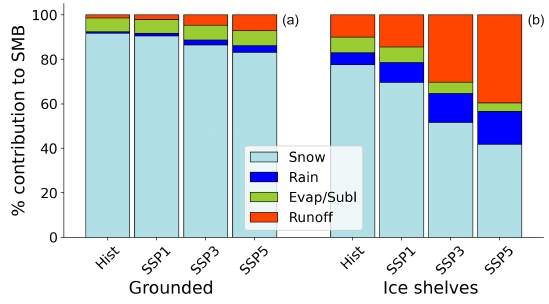
Figure A10. The contribution of snowfall, rainfall, evaporation/sublimation, and runoff to the total CESM2 SMB signal over the (a) grounded ice sheet and (b) ice shelves at the end of the historical period (2005–2015) and at the end of future scenarios of SSP1–2.6, SSP3–7.0, and SSP5–8.5